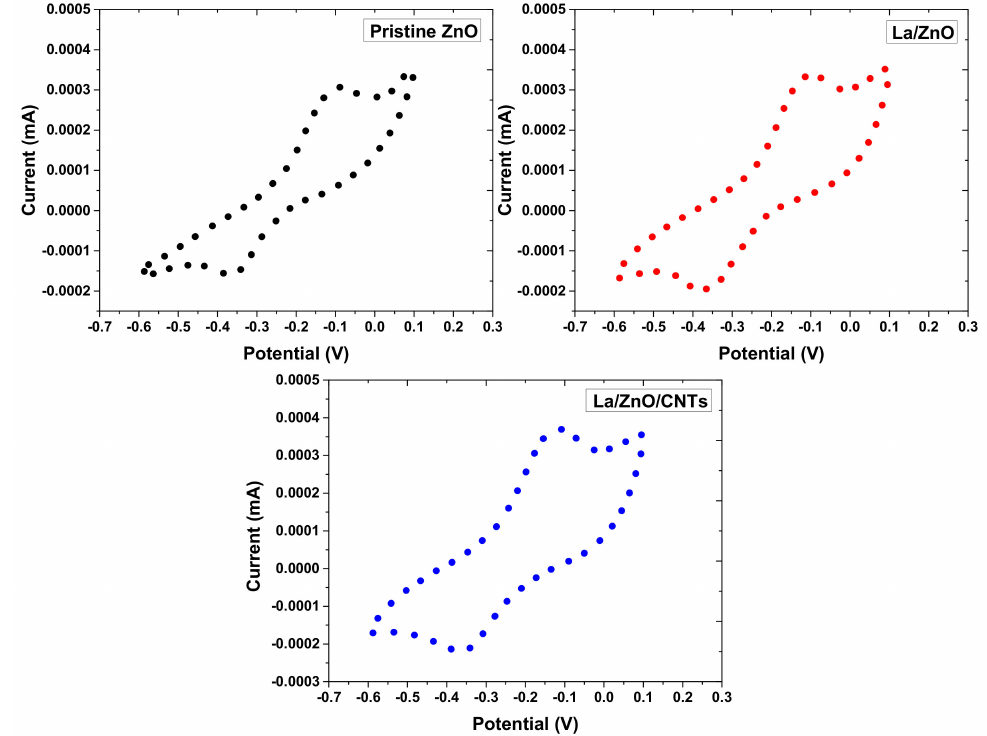
Figure 7. Cyclic voltammetry profiles of pristine ZnO, La/ZnO, and La/ZnO/CNTs composite